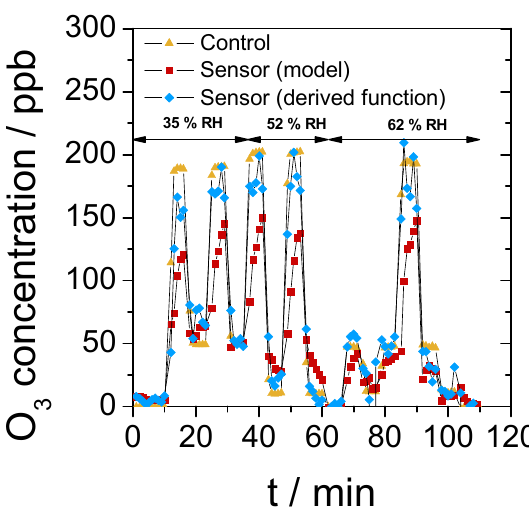
Figure 7. O 3 concentration measured as function of time with a benchtop O 3 analyzer for control (triangle) and the sensor using Equation (3) (square) or the derivative as a function of time (Equation (4), lozenge). In this scenario, the O 3 concentration was varied every five to ten minutes from 0 to 10 or 50 or 200 ppb, and the relative humidity in air was changed from 35% to 52% and, finally, 62%.